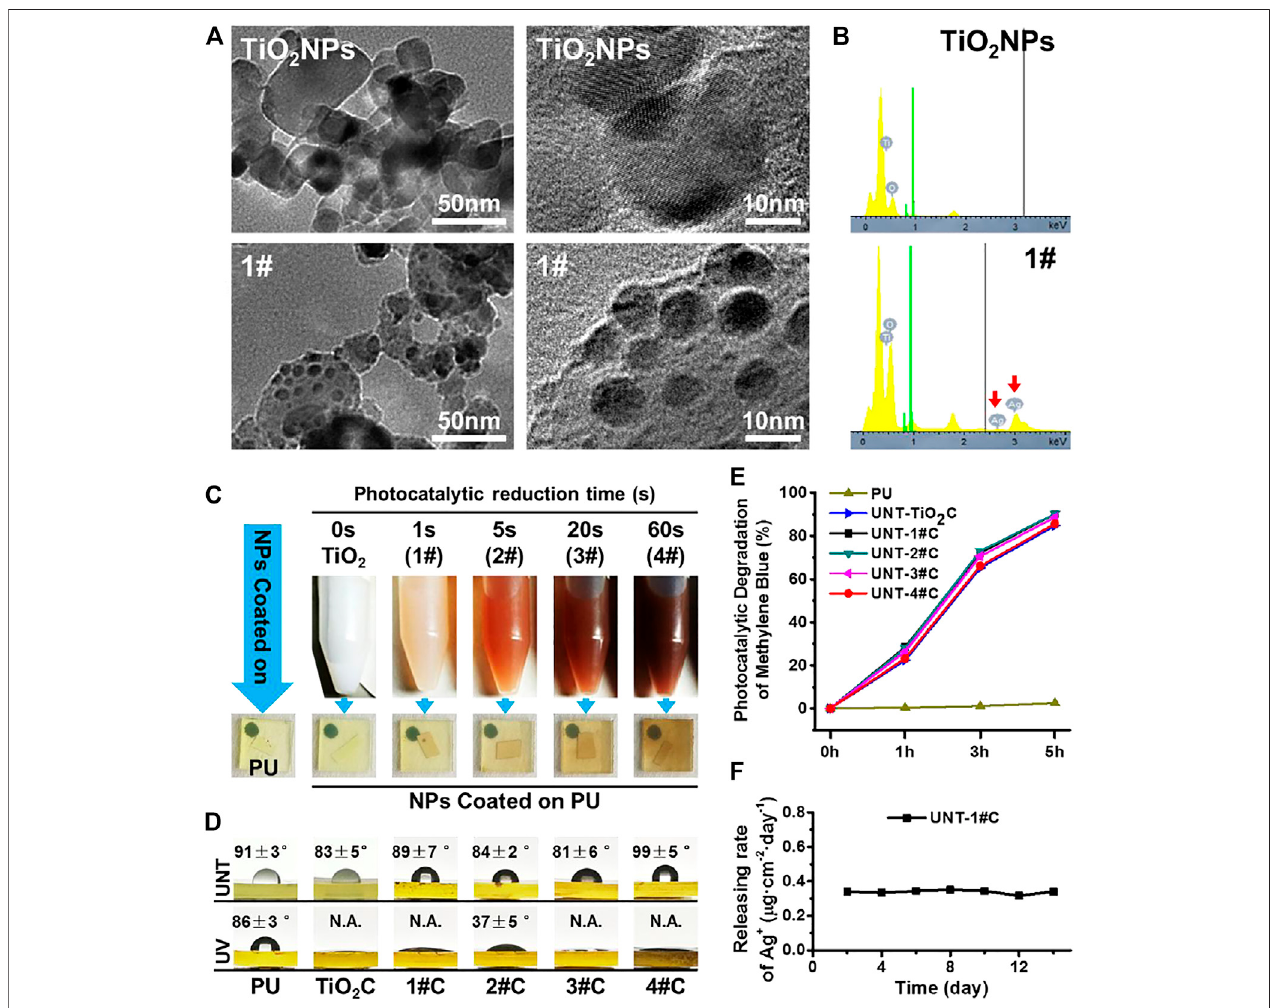
FIGURE2| TEMmicroscopicimagesofTiO 2 NPsbeforeandafterphotocatalyticreductioninsilvernitratesolution (A) andtheresultsofEDSelementalanalysis (B) ; photos of Ag@TiO 2 NPs suspensions and corresponding coating on PU sheets at different photocatalytic reduction times (C) ; WCA of Ag@TiO 2 NPs coatings on PU sheets before and after photo-functionalization (D) ; Untreated Ag@TiO 2 NPs coatings photocatalytic degrade of methylene blue (E) ; Ag + release from UNT-1# coating (F) .